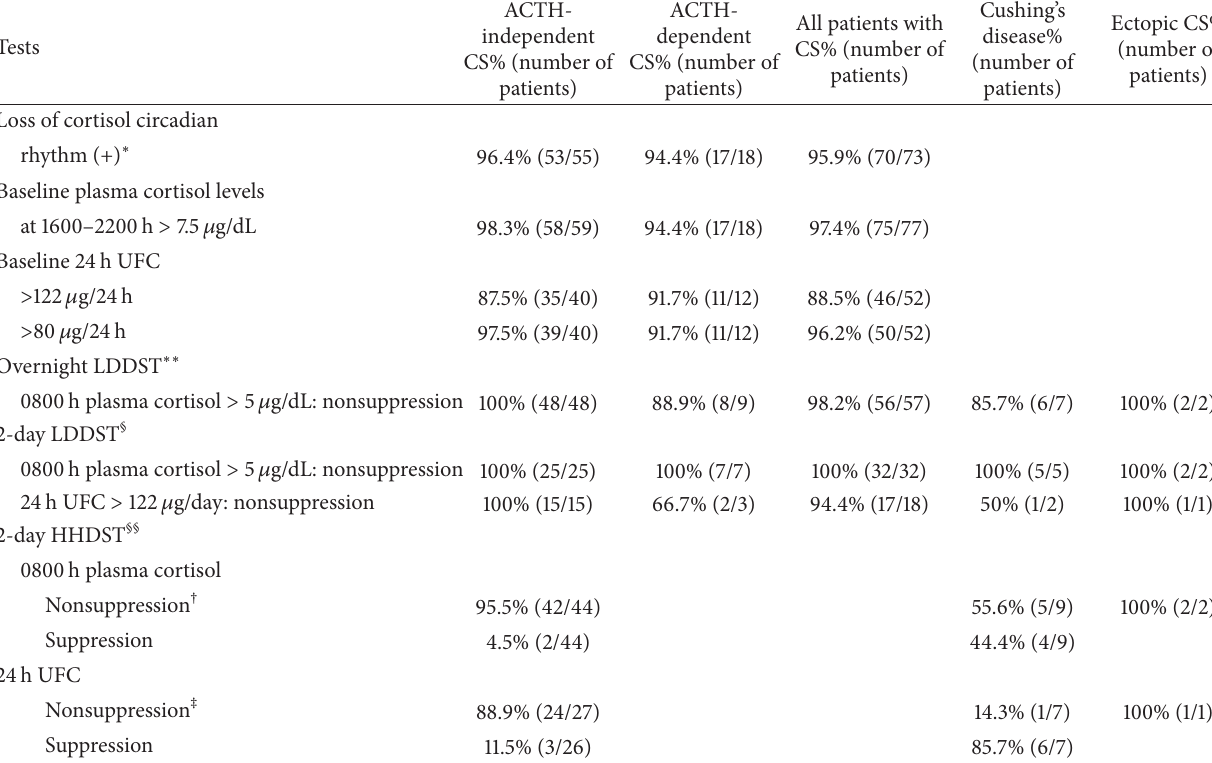
Table 2: Test results for ACTH-independent CS and ACTH-dependent Cushing’s syndrome (CS) in the 84 patients studied.